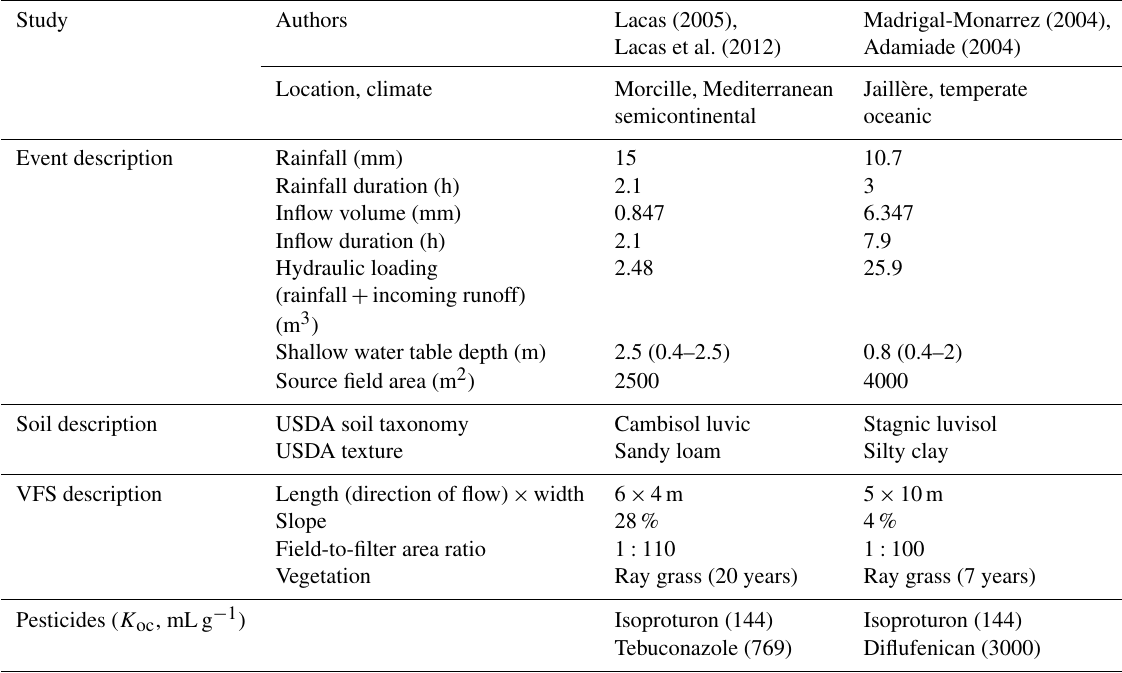
Table 1. Characteristics of the field studies utilized for sensitivity–uncertainty analyses of shallow water table effects on VFS performance. Study Authors